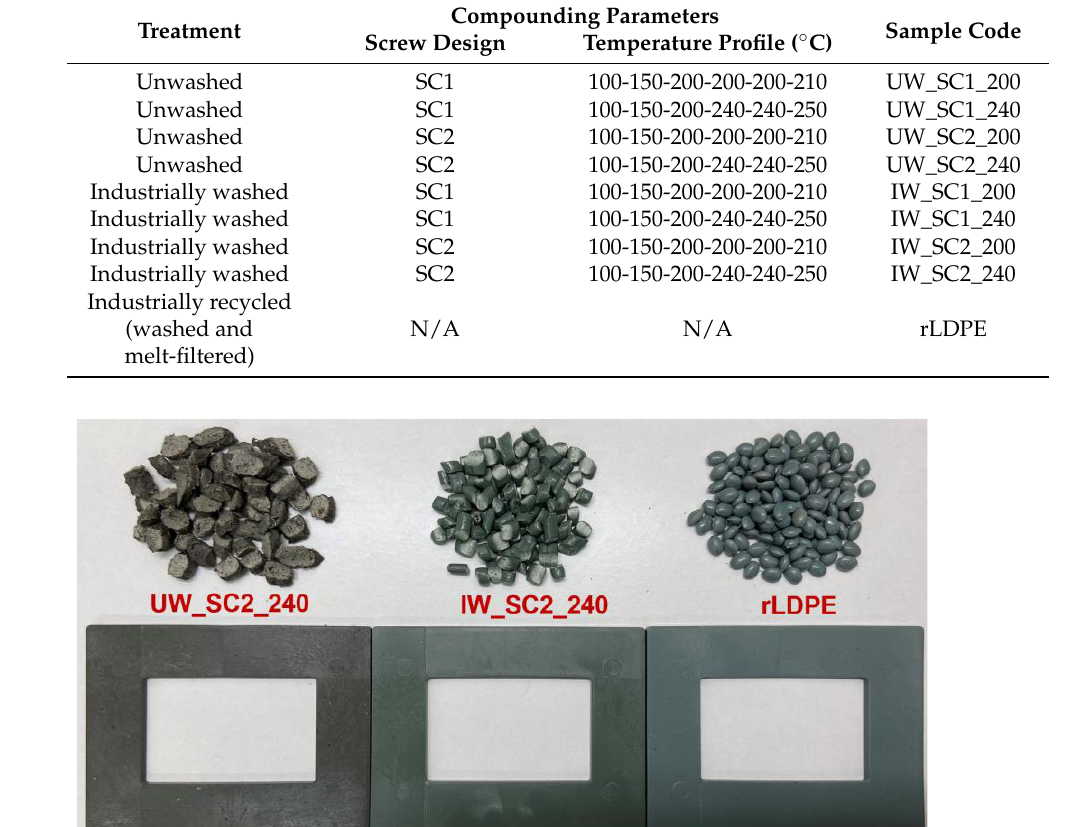
Table 1. The samples’ codes and processing histories. Table 1. The sample s’ codes and processing histories.